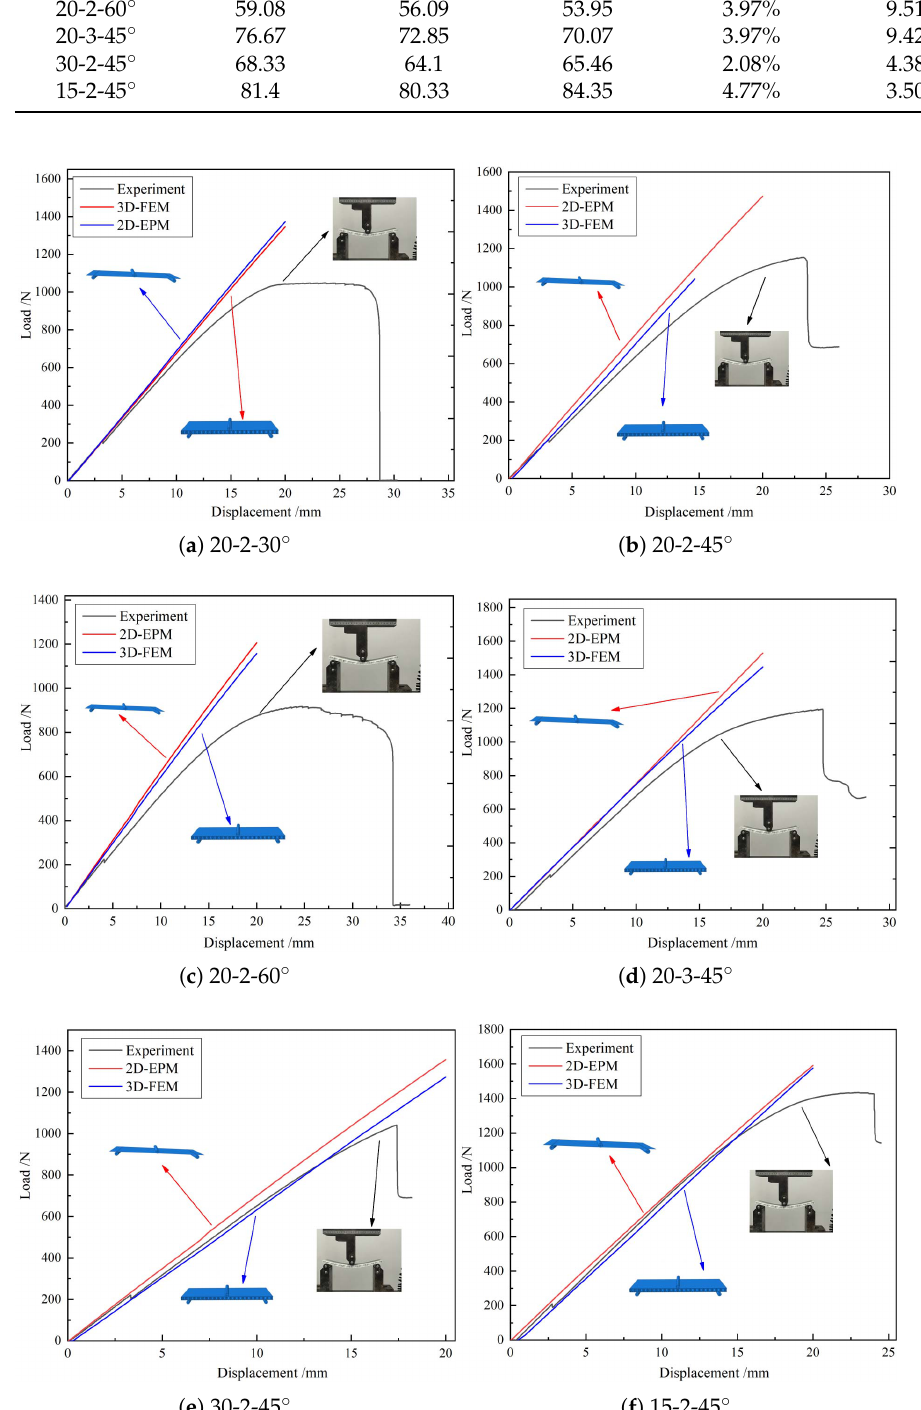
Figure 4. Displacement-load curves from experiments, 2D-EPM, and 3D-FEM ( l - t - α denotes cell side length, core wall thickness and included